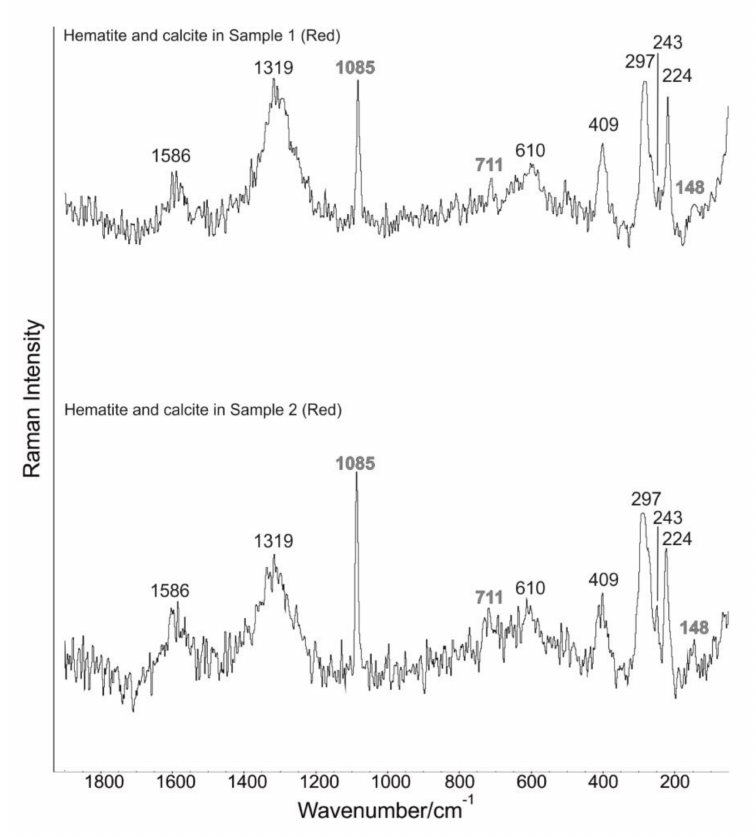
Figure 7. Raman spectra of hematite for Samples 1 and